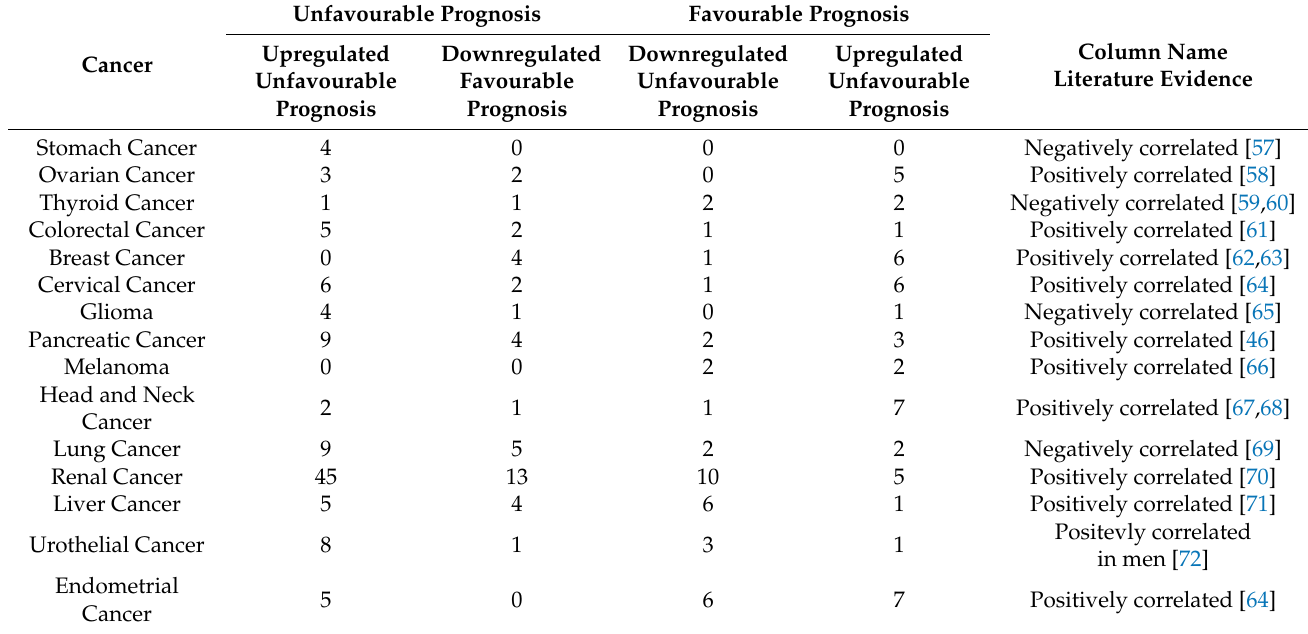
Table 3. Prognosis score associated with each cancer. Unfavorable or favorable prognosis was assessed according to orange or blue edges, respectively. Upregulated or downregulated genes were described according to their log2FC. A bibliographic search was performed to assess previous correlations of each cancer type with